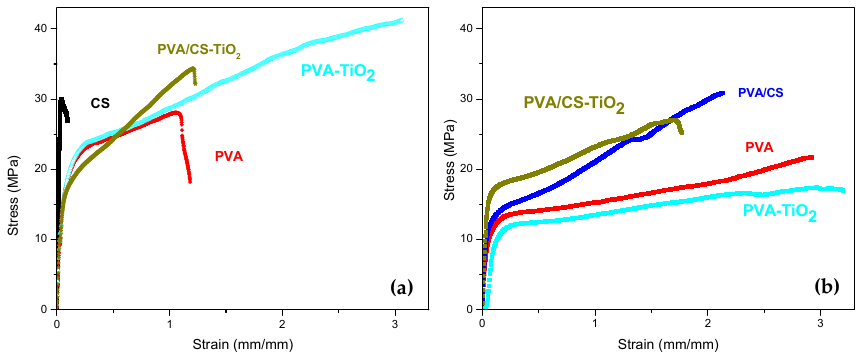
Figure 7. Stress–strain curves: ( a ) PVA / CS compound (1000 ppm TiO 2 ) and precursors. ( b ) 2 M-doped KOH membranes. Crosshead speed 20 mm /